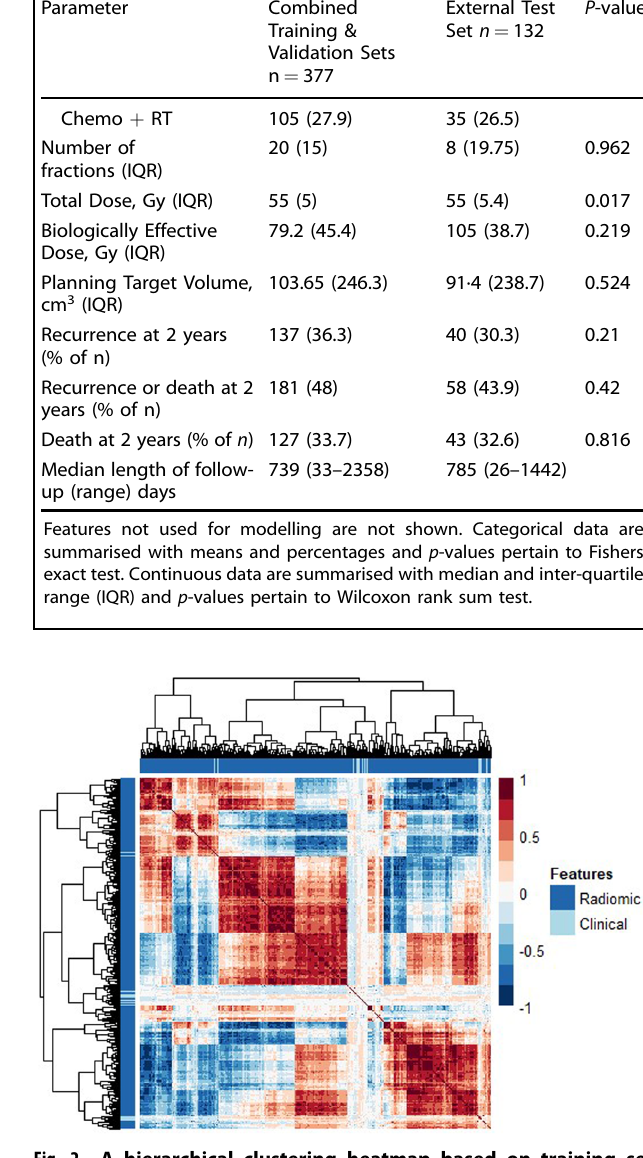
Fig. 2 A hierarchical clustering heatmap based on training set data shows correlation between radiomic and clinical features, with all features on the X and Y axes respectively. Axis trees show a number of groups based on sample-wise